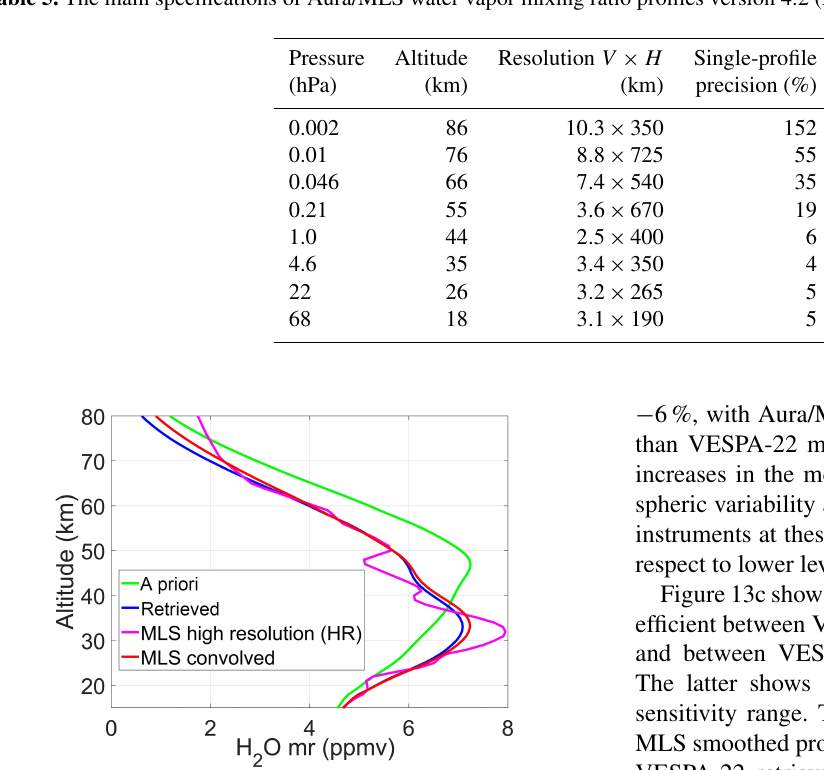
Table 5. The main specifications of Aura/MLS water vapor mixing ratio profiles version 4.2 (Livesey et al., 2015).